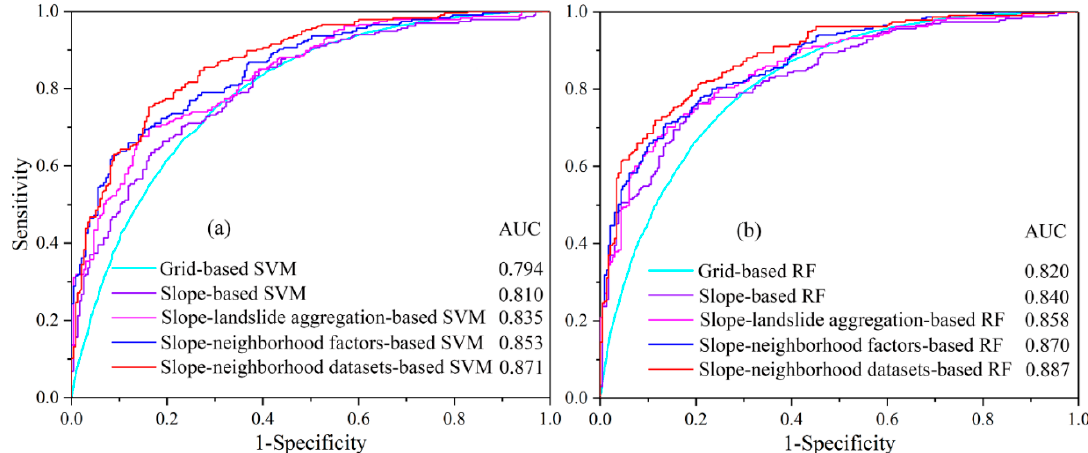
Figure 9. The ROC under different combination conditions. ( a ) The AUC of SVM; ( b ) The AUC of RF. The SVM models considering the neighborhood characteristics of the spatial datasets have a better performance and a significantly higher prediction accuracy than the grid units under the original conditions. The SVM model are taken as an example, and the AUC accuracy is as follows: grid-based SVM (0.794) < slope-based SVM (0.810) <